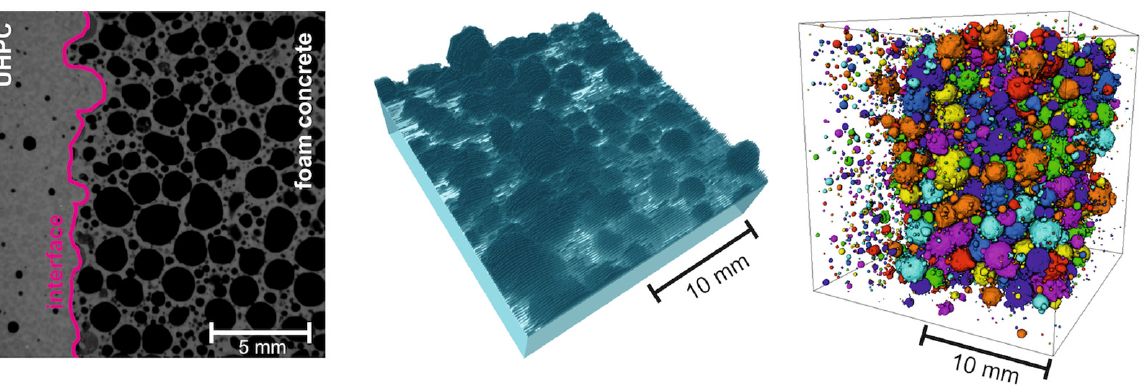
Figure 1. Visualization of the transition zones and pore space of different concretes using CT [22].